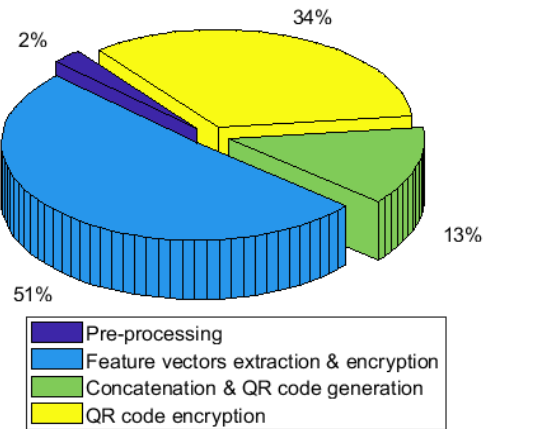
Figure 11. Percentage corresponding to the execution time of the proposed scheme’s steps.